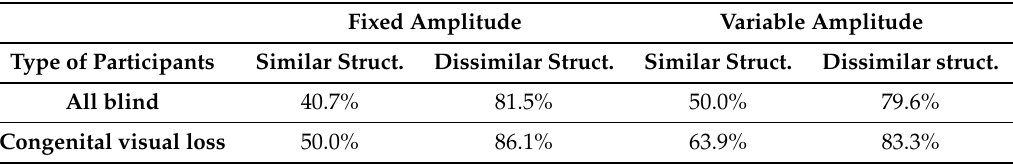
Table 5. Congenital vision loss effect on